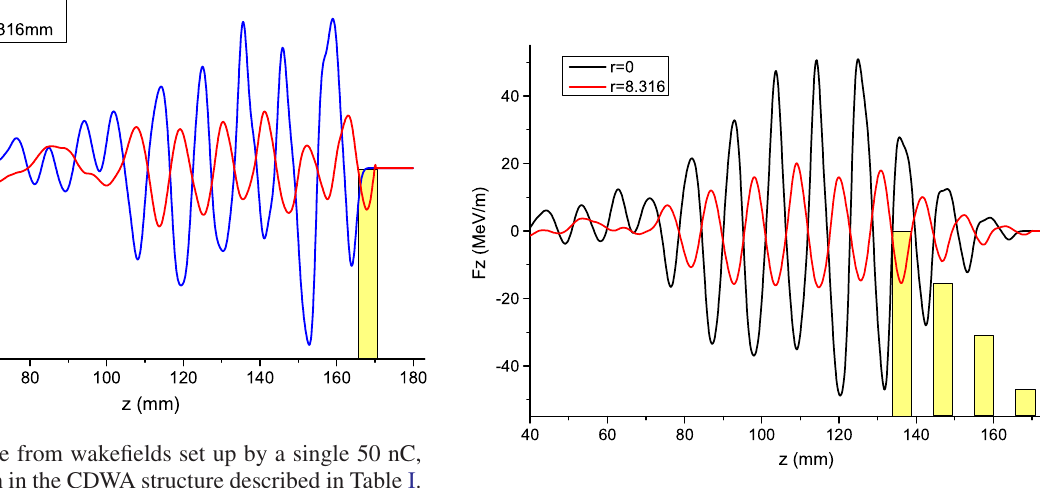
FIG. 4. Same as for Fig. 3, but now the bunch charge is increased as the ratio of odd